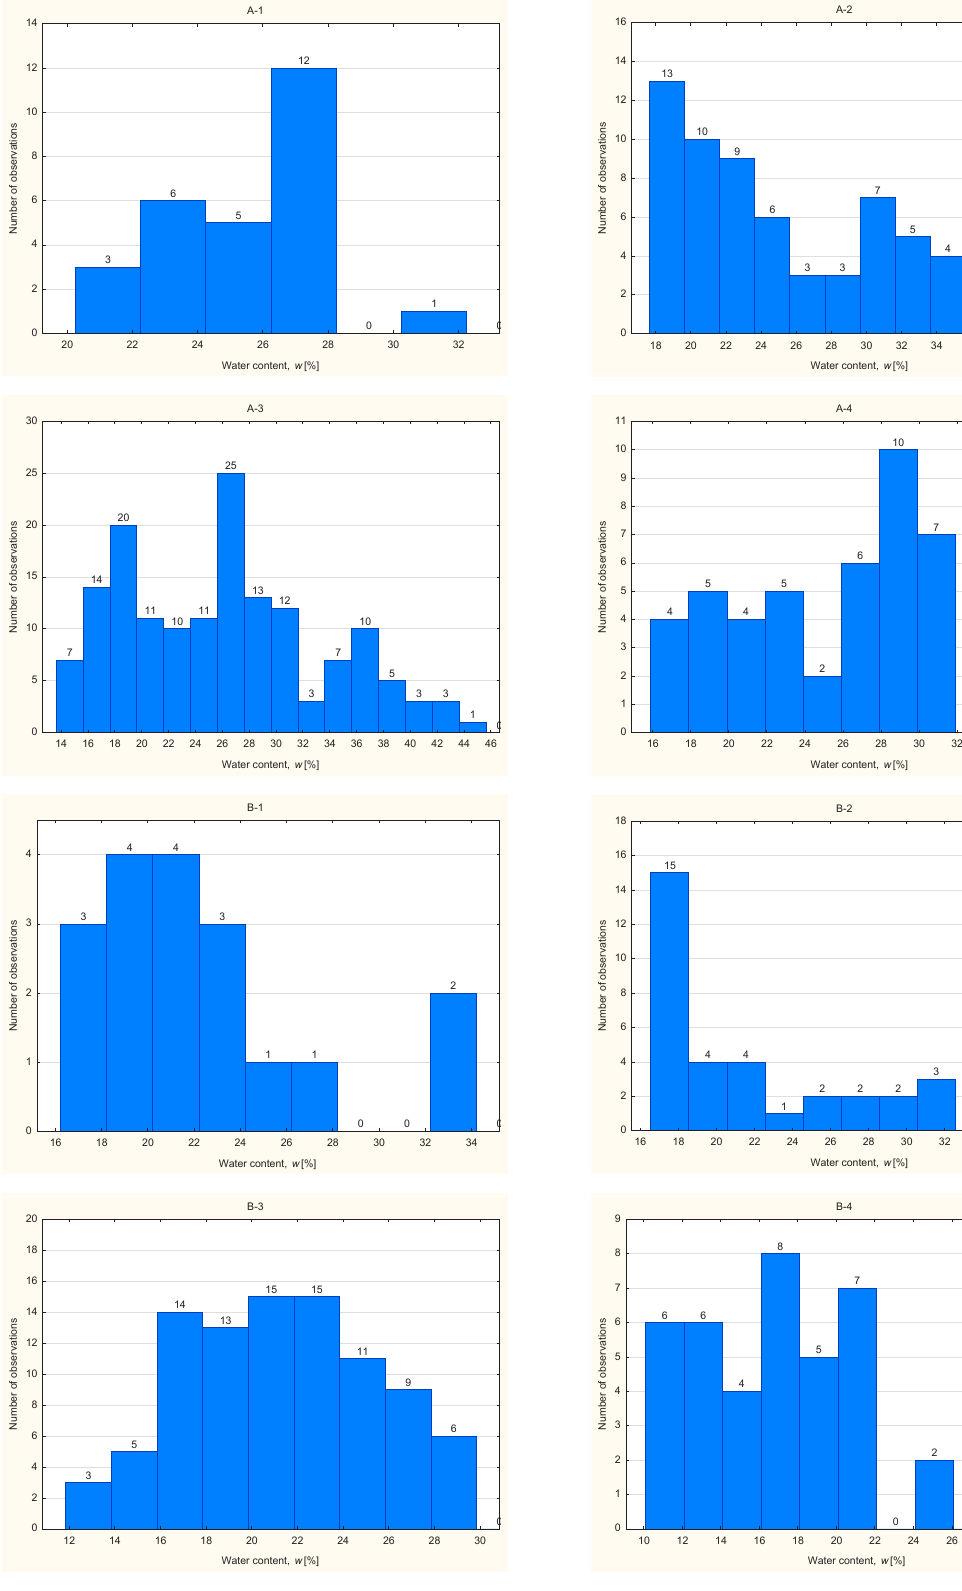
Fig. 3. Histograms of water content distribution of the dump soil in particular groups Figure 3: Histograms of water content distribution of the dump soil in particular